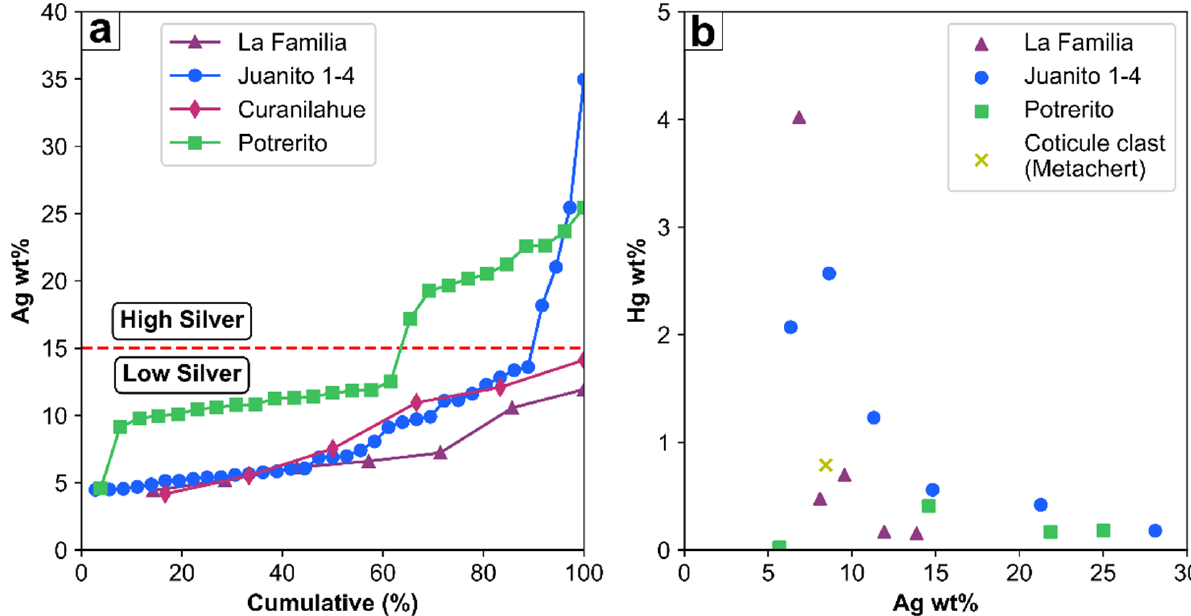
Figure 5. Compositions of native gold particle cores determined with SEM-EDS and EMPA anal- yses. ( a ) Cumulative frequency plots for semi-quantitative core silver contents obtained with SEM- EDS. ( b ) Variations in quantitative silver and mercury contents obtained with EMPA. The compo- sition of a gold grain found as a pyrite inclusion in a “coticule” (metachert) clast is shown. Particles with lower silver contents show the highest mercury contents.